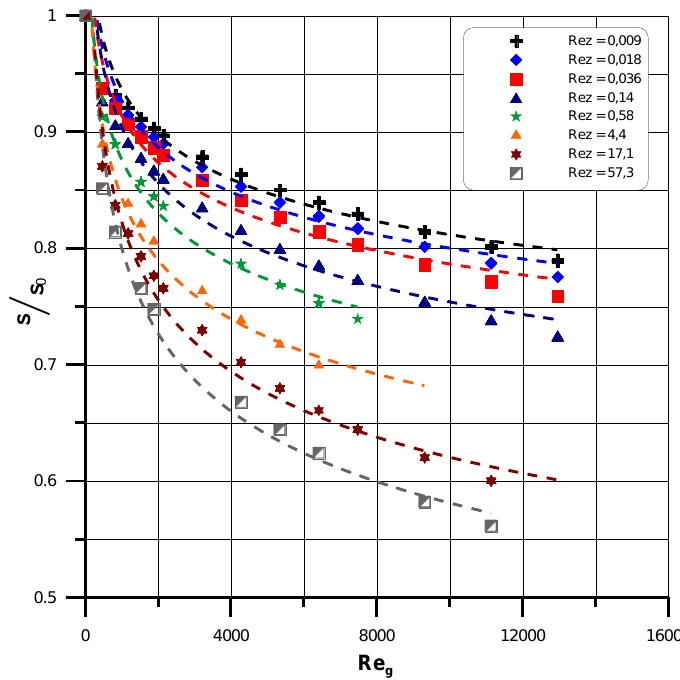
Figure 2. Graphical illustration of Equation (2) describing the effect of gas flow rate on liquid film thickness during two-phase flow and film thickness in the case of gravitational run-off.